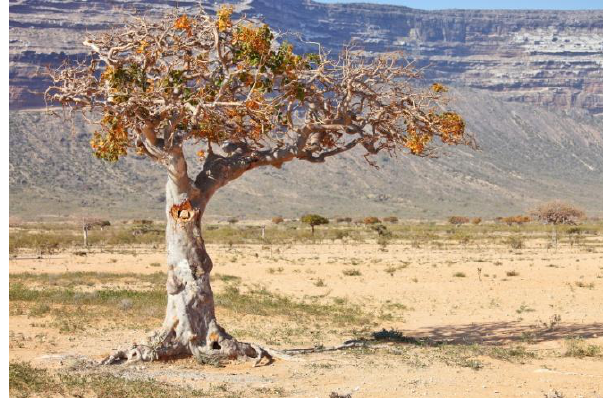
Figure 2: Tree of Myrrh. Picture extracted from reference 4. Based on the traditions and culture in Egypt, C. myrrh is believed to be more effective in treating infectious diseases, including the Trichomoniasis vaginalis infection. It is believed that the use of myrrh extracts is safe in reproductive organs of males [12]. The extracts are used